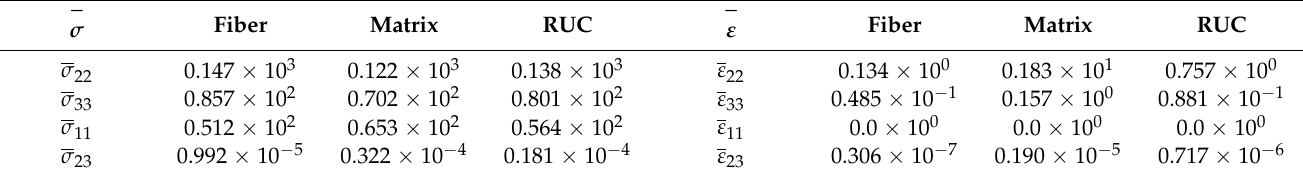
Table 3. Average values of stress and strain (Case